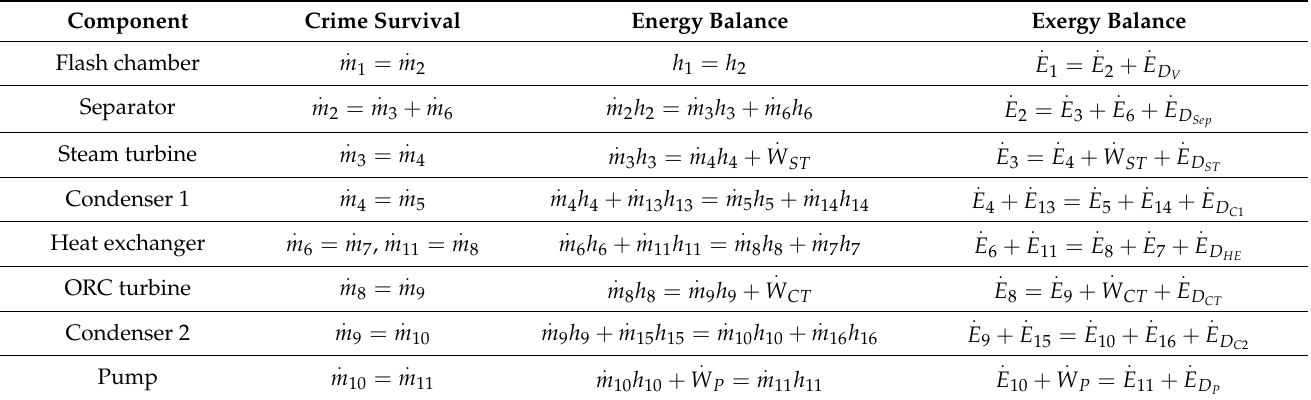
Table 4. Relationships between the first and second laws of thermodynamics and the law of conser- vation of mass for each component of the system